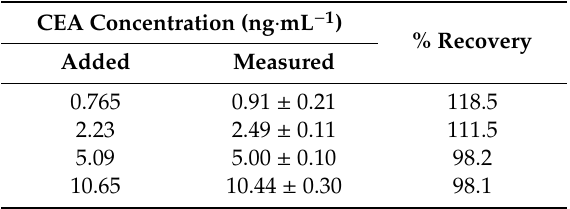
Table 1. Determination of CEA in human serum samples ( n =